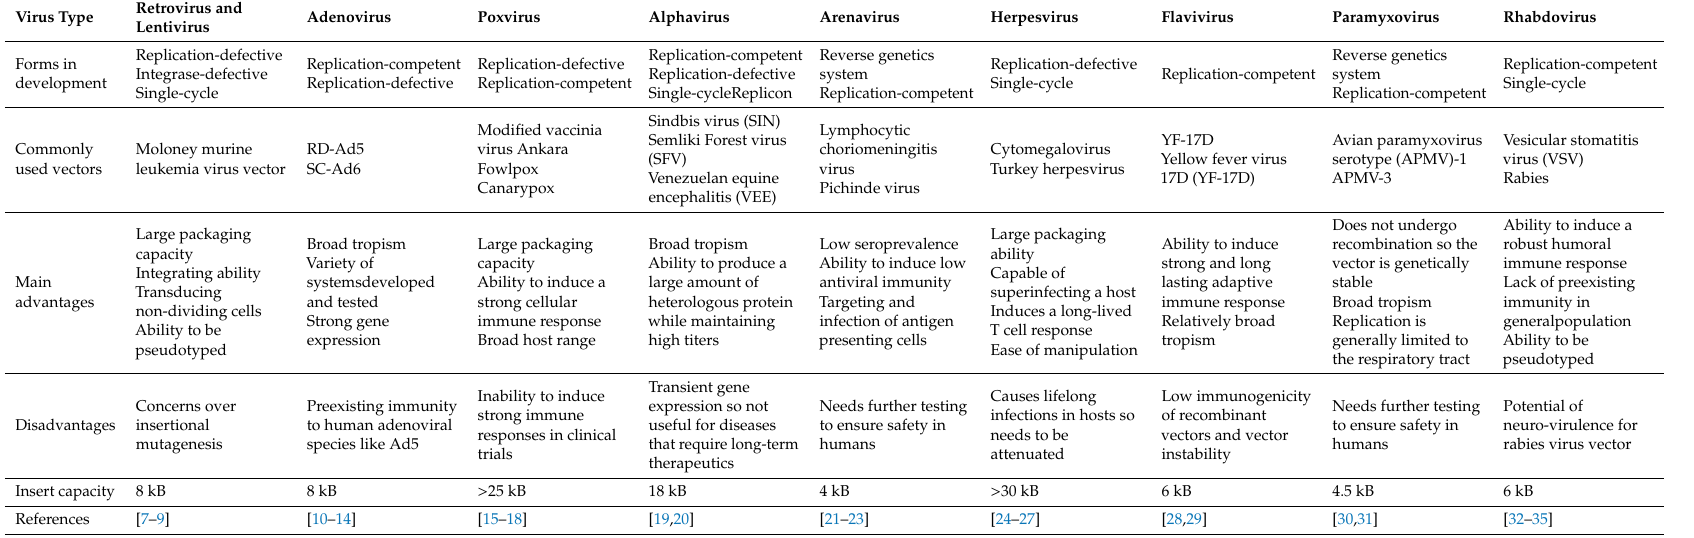
Table 1. Known viral vectors used in vaccine